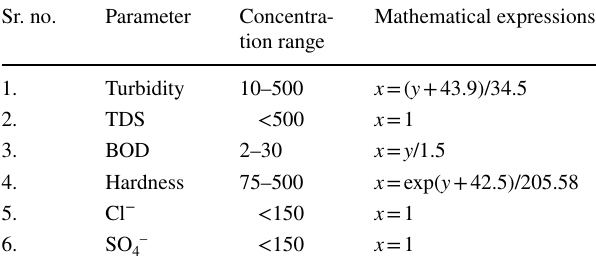
Table 2 Mathematical expressions for value function curves (Sar- goankar and Deshpande 2003) Sr. no.